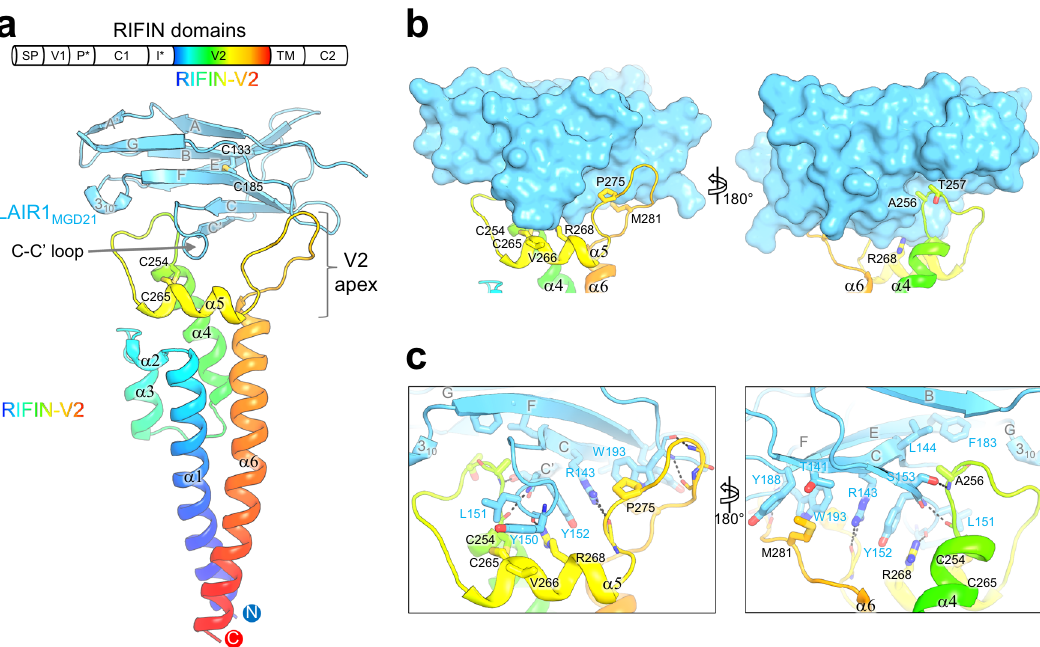
Fig. 1 Structure of RIFIN-V2 in complex with LAIR1. a Schematic view of A-RIFIN domains (upper, SP: Signal peptide; V1: Variable domain 1; P*: PEXEL motif; C1: Conserved domain 1; I*: Indel motif; V2: Variable domain 2; TM: Transmembrane domain; C2: Conserved domain 2). Structure of RIFIN (PF3D7_1040300) V2 domain in complex with antibody MGD21 LAIR1 domain is presented as cartoon side view (lower). RIFIN-V2 domain is colored in rainbow. LAIR1 domain is colored in cyan. All secondary structural elements are labeled. b , Surface and pockets on LAIR-1 that accommodate RIFIN-V2 apex. c Detail of RIFIN-LAIR1 interface. Interface residues are shown with side chains as sticks and